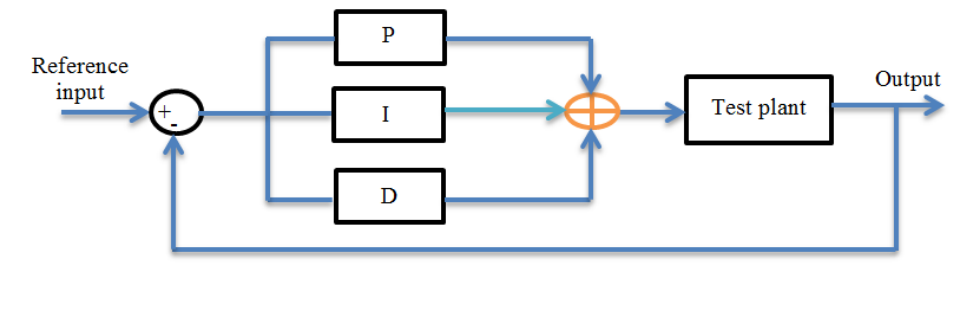
Fig. 1. Control system